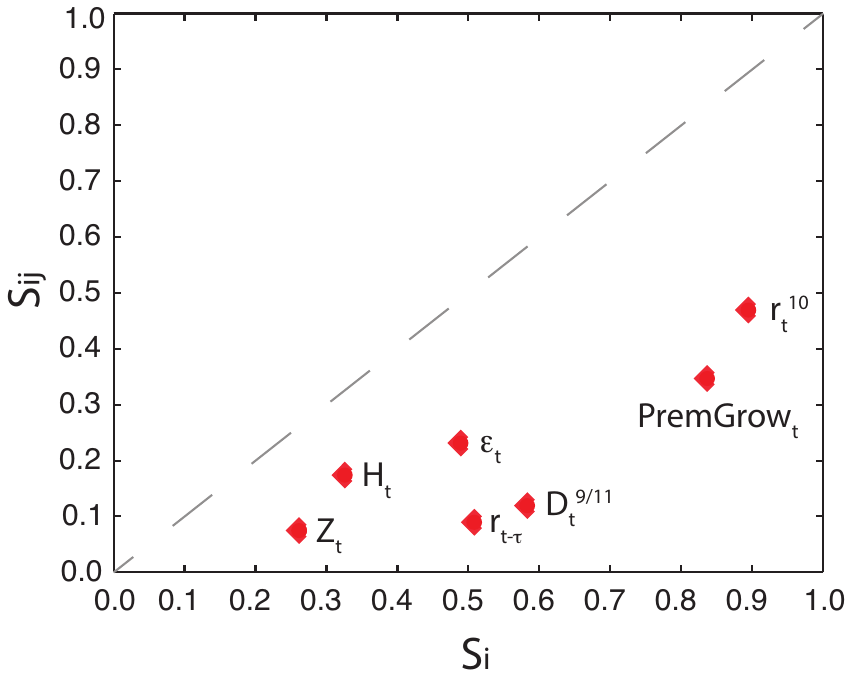
Figure 6. First and second order sensitivity index ( S i and S ij ) for the ROE model. The number ( H t ) and mean intensity ( Z t ) of hurricanes are second-order factors in predicting ROE, thus they can be neglected by the